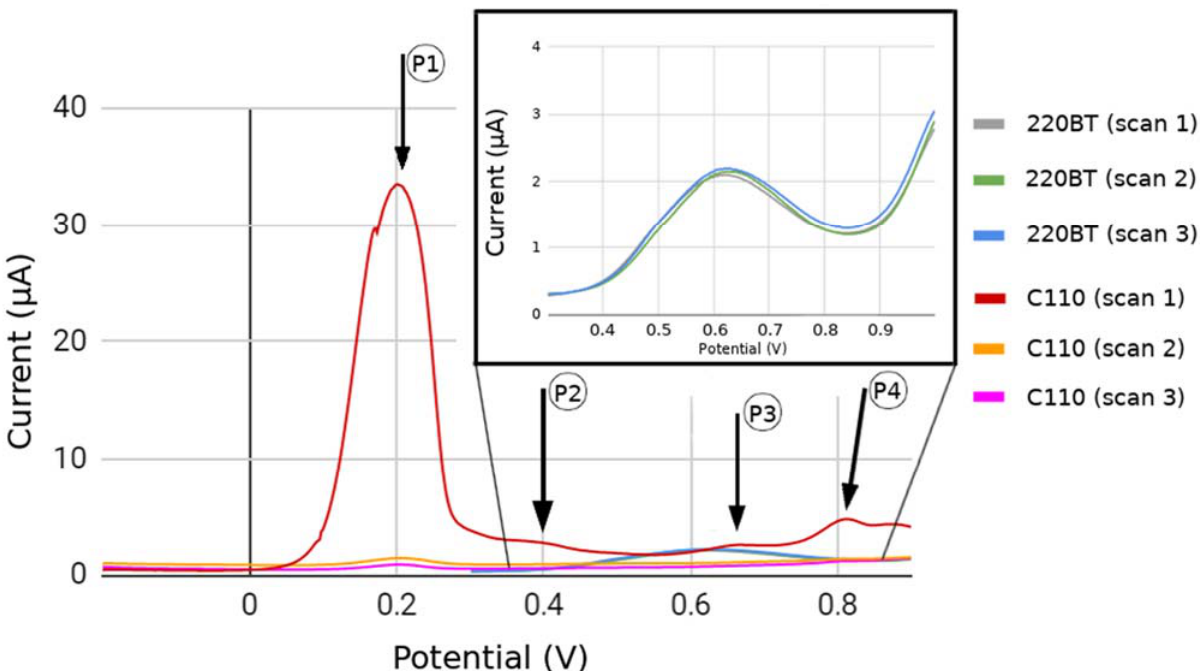
Figure 2. DPV for the first three scans of 4-DMAA (5 mmol.L − 1 ) on the screen-printed graphite electrode C110 and screen-printed gold electrode BT220 in phosphate-buffered electrolyte salt so- lution (pH 7.4). P1, P2, P3 and P4 are the four oxidation peaks from 4-DMAA obtained using the graphite